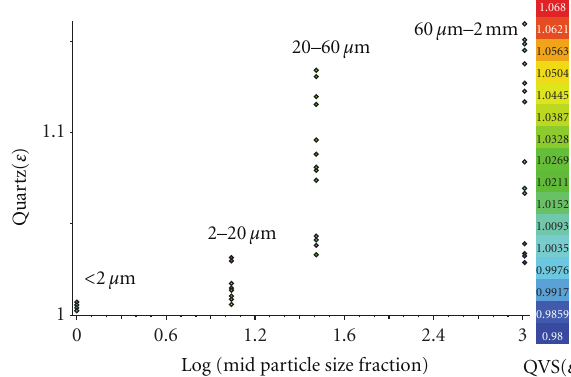
Figure 6: Quartz content spectral index (Quartz( ε )) versus log of the particle size fraction and colour coded by the fine quartz volume scattering (QVS( ε ) (e.g., red = high scattering associated with fine quartz), showing an approximate decrease in quartz content with decreased grain size.